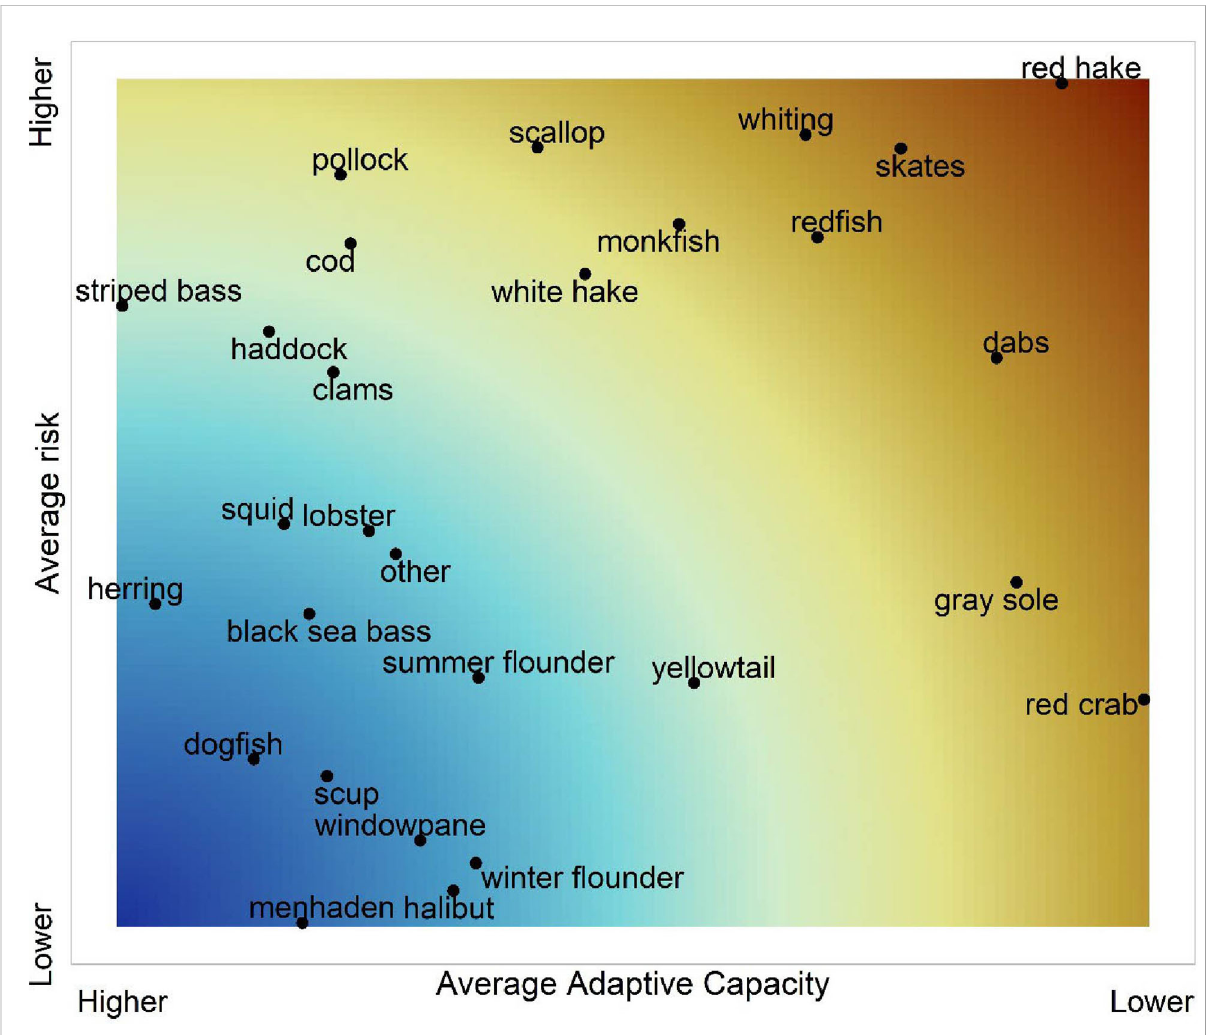
FIGURE 5 Average relative vulnerability of survey respondents participating in Northeast commercial fi sheries indicated by the distance from the origin in a space de fi ned by risk (exposure and sensitivity) and adaptive capacity. The colored bands represent similar levels of perceived vulnerability. Since higher adaptive capacity reduces vulnerability, the adaptive capacity axis goes from highest to lowest calculated